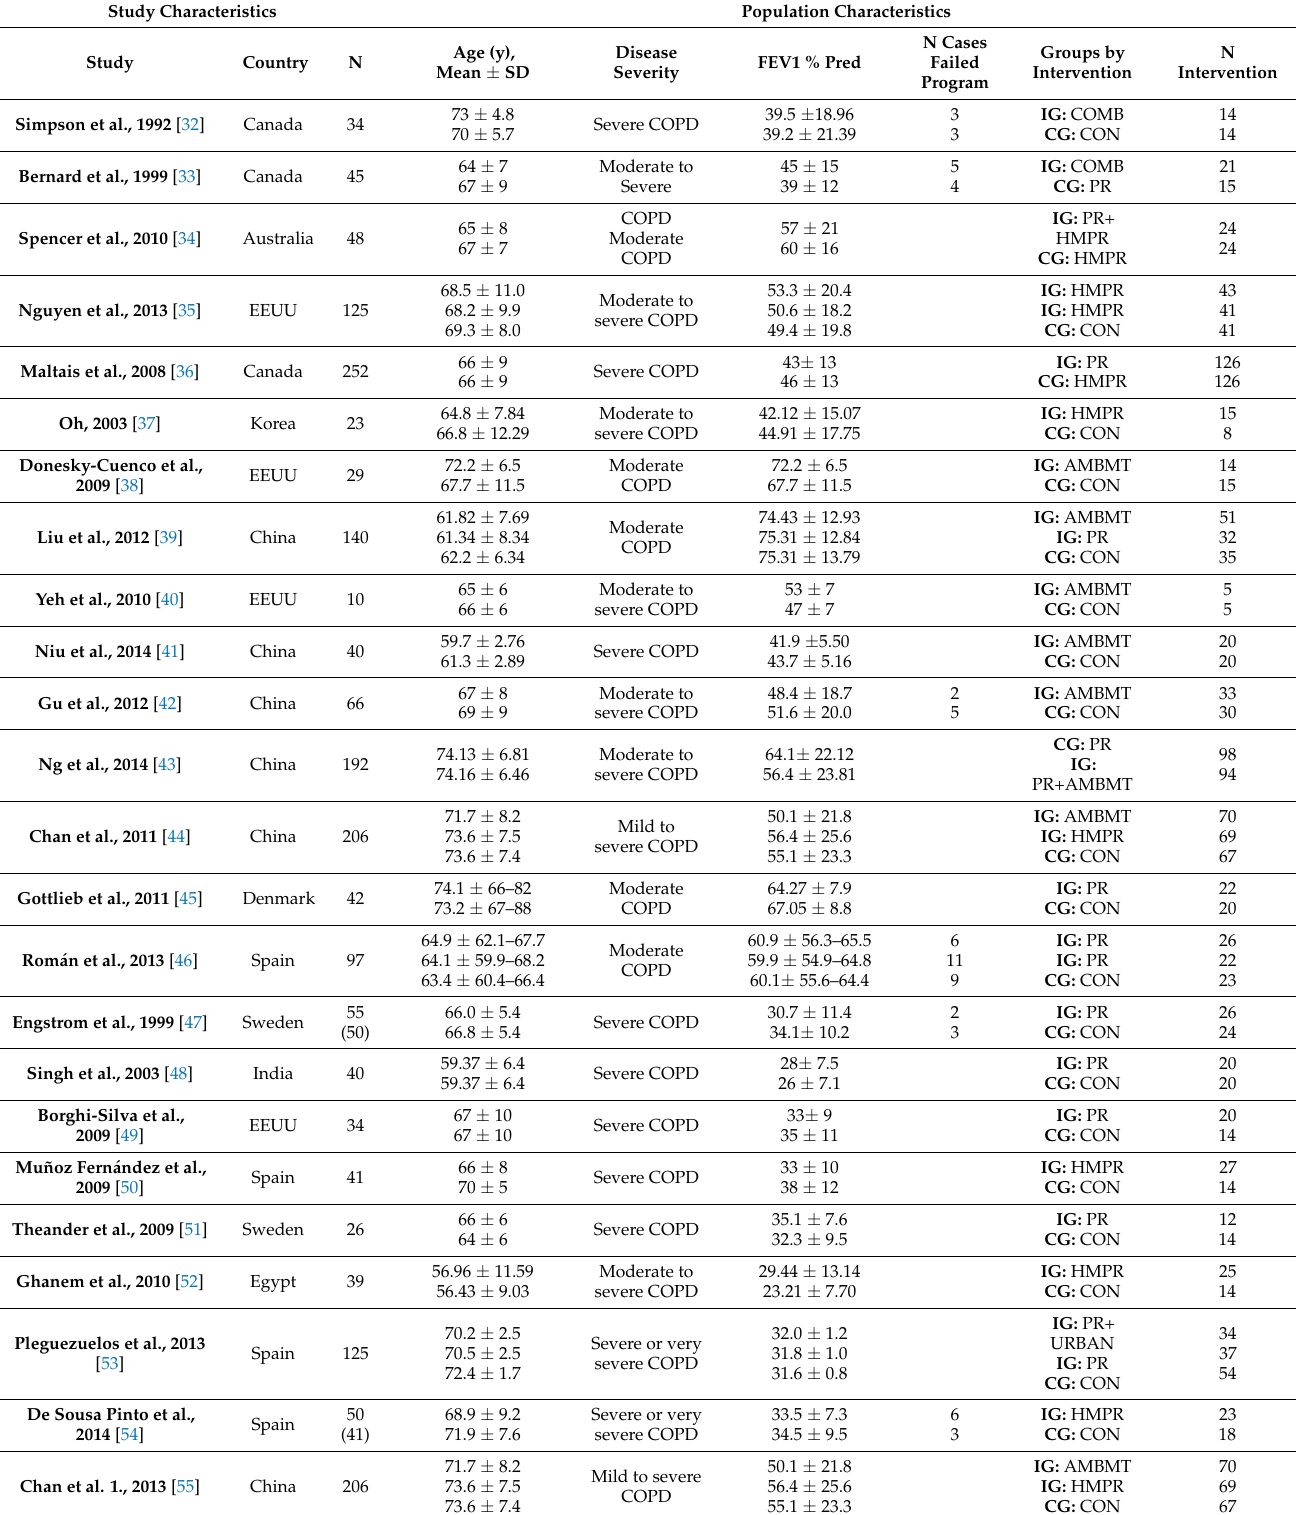
Table 1. Characteristics of the population described in the included